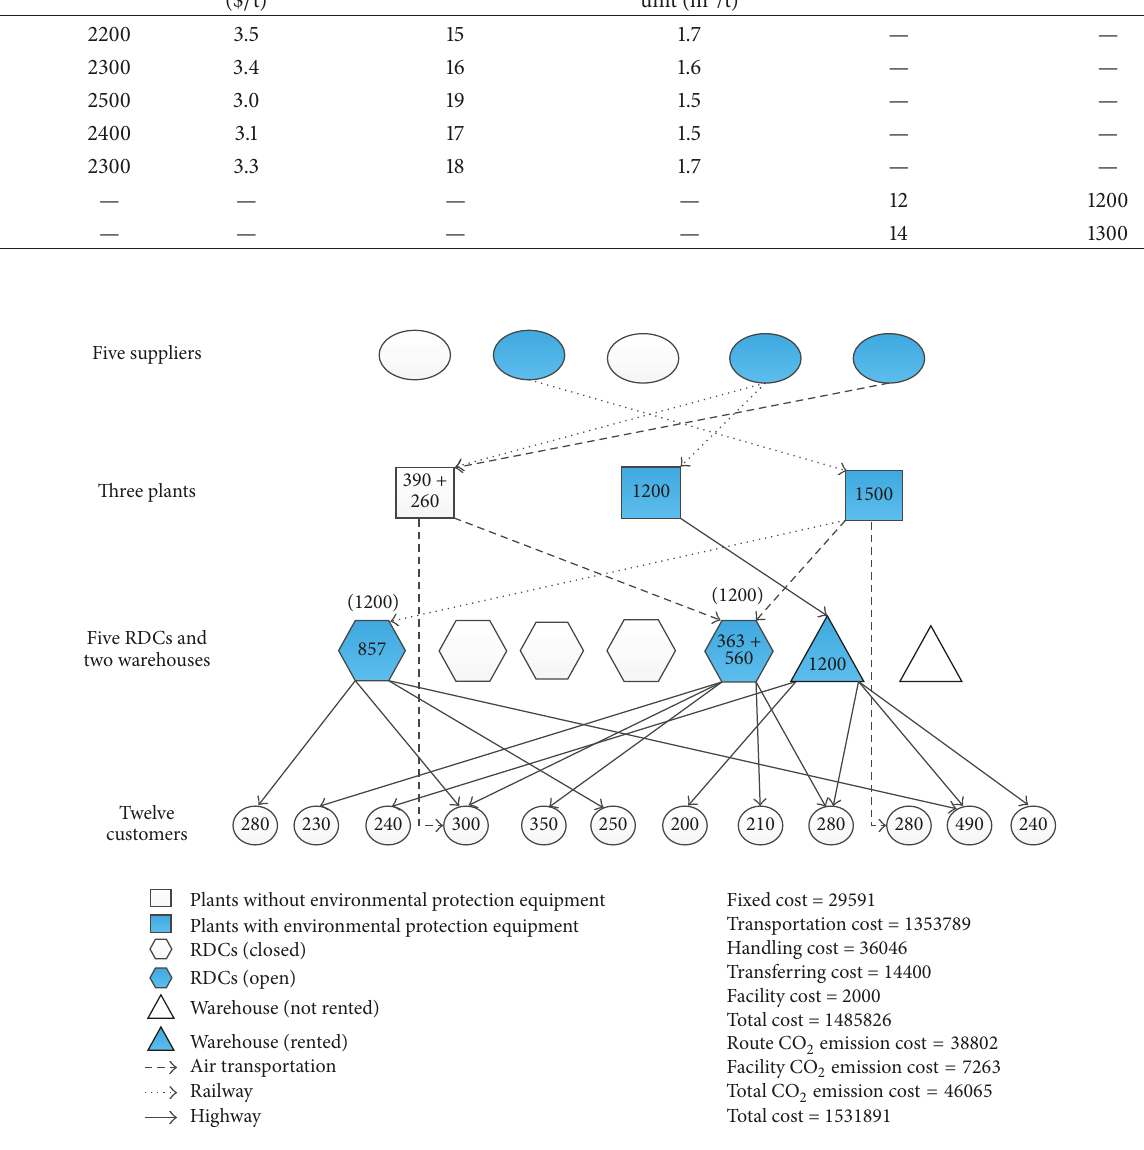
3.3. Effects of the Parameter Value of Economies of Scale on the Network Design of the Green Supply Chain. Other parameters remain unchanged to test the scaling parameters of the optimal network design. Installing additional capacity adds to the cost by examining a series of economies of scale factors, which modify the economy of scale parameter in analyzing its effect on the optimal number and size of RDCs. The results are shown in Table 11. The warehouse located at node 6 is selected for the entire time in Figure 4. The size of RDCs is drastically different from the original case. When the economies of scale parameter